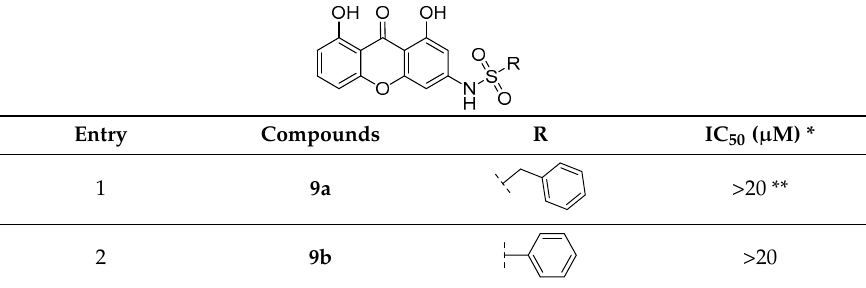
Table 1. Inhibitory activities of 9a – 9n against PGAM1.